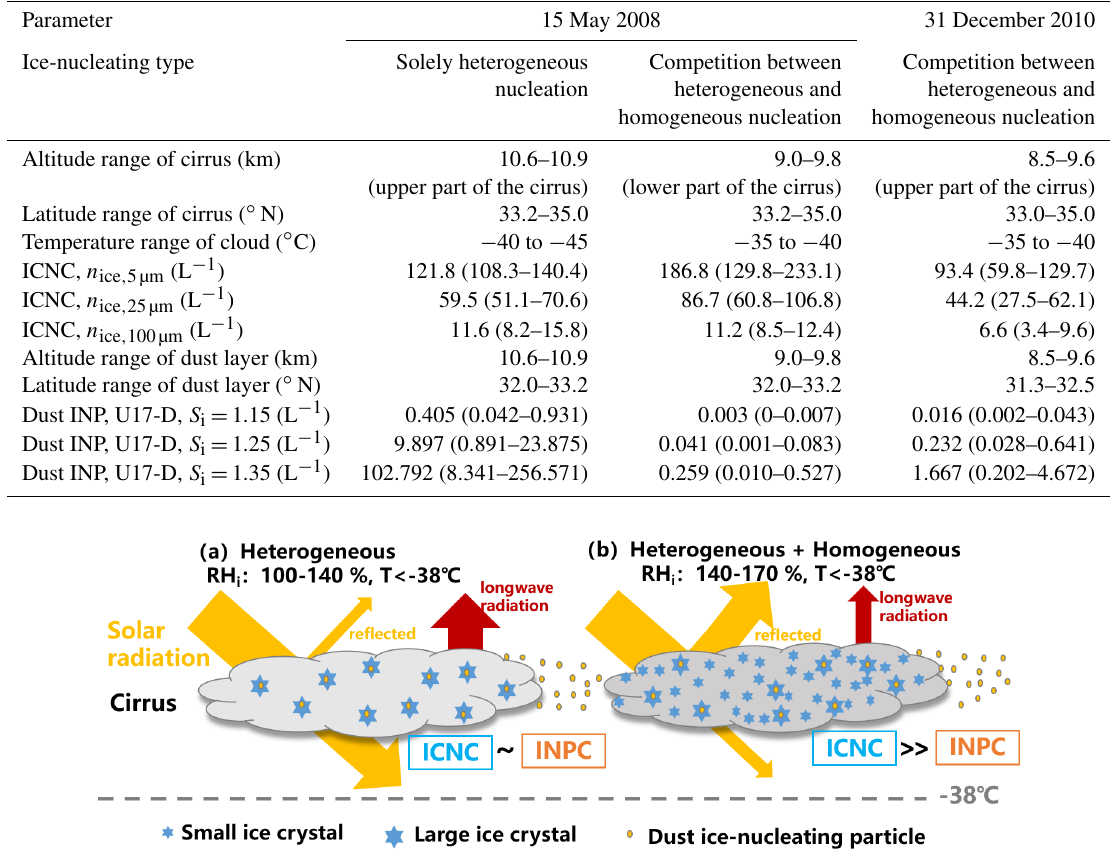
Figure 12. Schematic illustration of the two ice-nucleating mechanisms of the dust-related cirrus clouds (i.e., cirrus occurs accompanied by dust particles ambient). (a) Heterogeneous nucleation solely takes place with the RH i of 100%–140% and temperature of < − 38 ◦ C. The ice crystals within the cirrus are relatively larger, and the ICNC within the cirrus is comparable to the ambient dust INPC. This type of cirrus is always more transparent and allows more solar radiation to enter the middle and lower troposphere, while more longwave radiation can be emitted to space. This “seeded cirrus” may result in a net cooling effect, partially offsetting the warming effect of cirrus clouds on the Earth’s atmosphere (Kuebbeler et al., 2014; Lohmann and Gasparini, 2017). (b) Competition between heterogeneous and homogeneous nucleation with the RH i of 140%–170% and temperature of < − 38 ◦ C. Besides the large ice crystals formed by heterogeneous nucleation, there are also numerous smaller ice crystals within the cirrus produced via homogeneous nucleation (Krämer et al., 2020). The ICNC within the cirrus is far beyond (1 to several orders of magnitude) the ambient dust INPC (Froyd et al., 2022). This type of cirrus is optically denser and can reflect more solar radiation into space; however, less longwave radiation can be emitted to